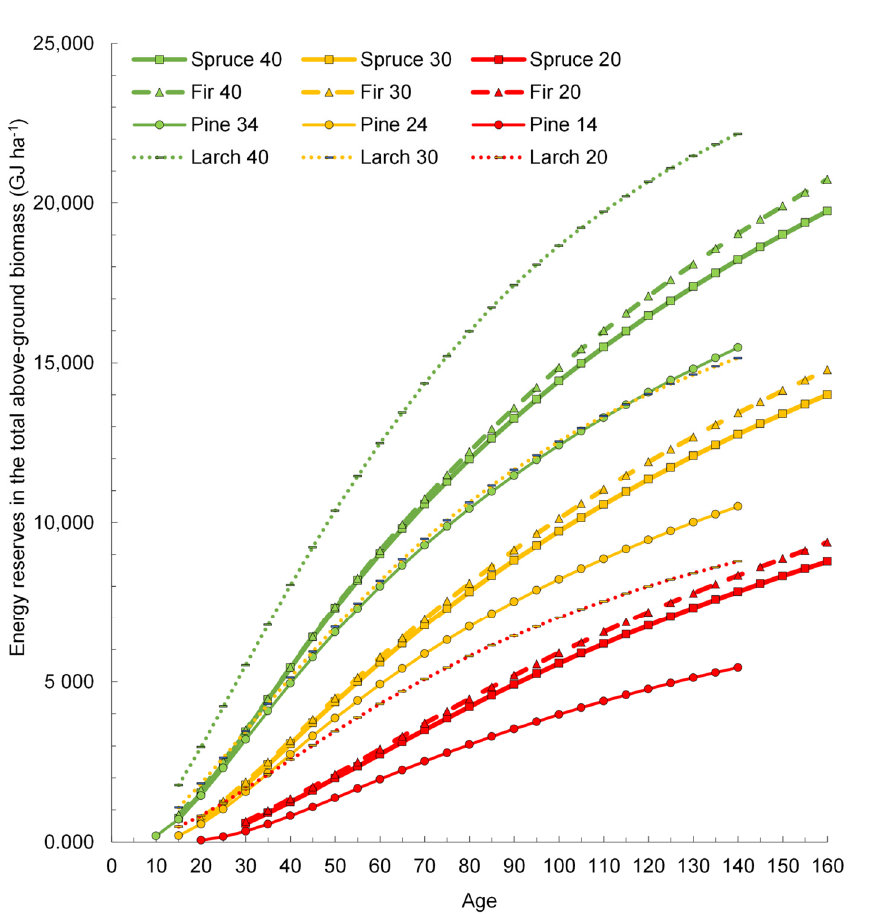
Figure 5. Development of energy reserves in the total above-ground biomass of coniferous stands depending on the stand age and site index (20, 30, 40 for spruce, fir and larch; 14, 24, 34 for pine). The development of the energy reserves in the above-ground biomass of stands from the point of view of forest management can be seen in Table 5.